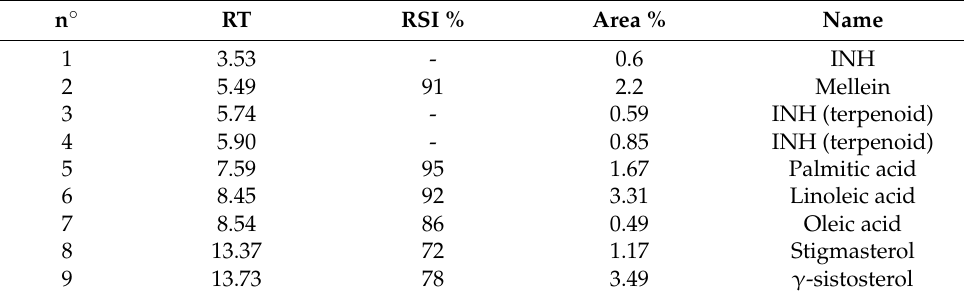
Table 6. GC-MS results of petroleum ether fraction of D. oliveri trunk bark. n